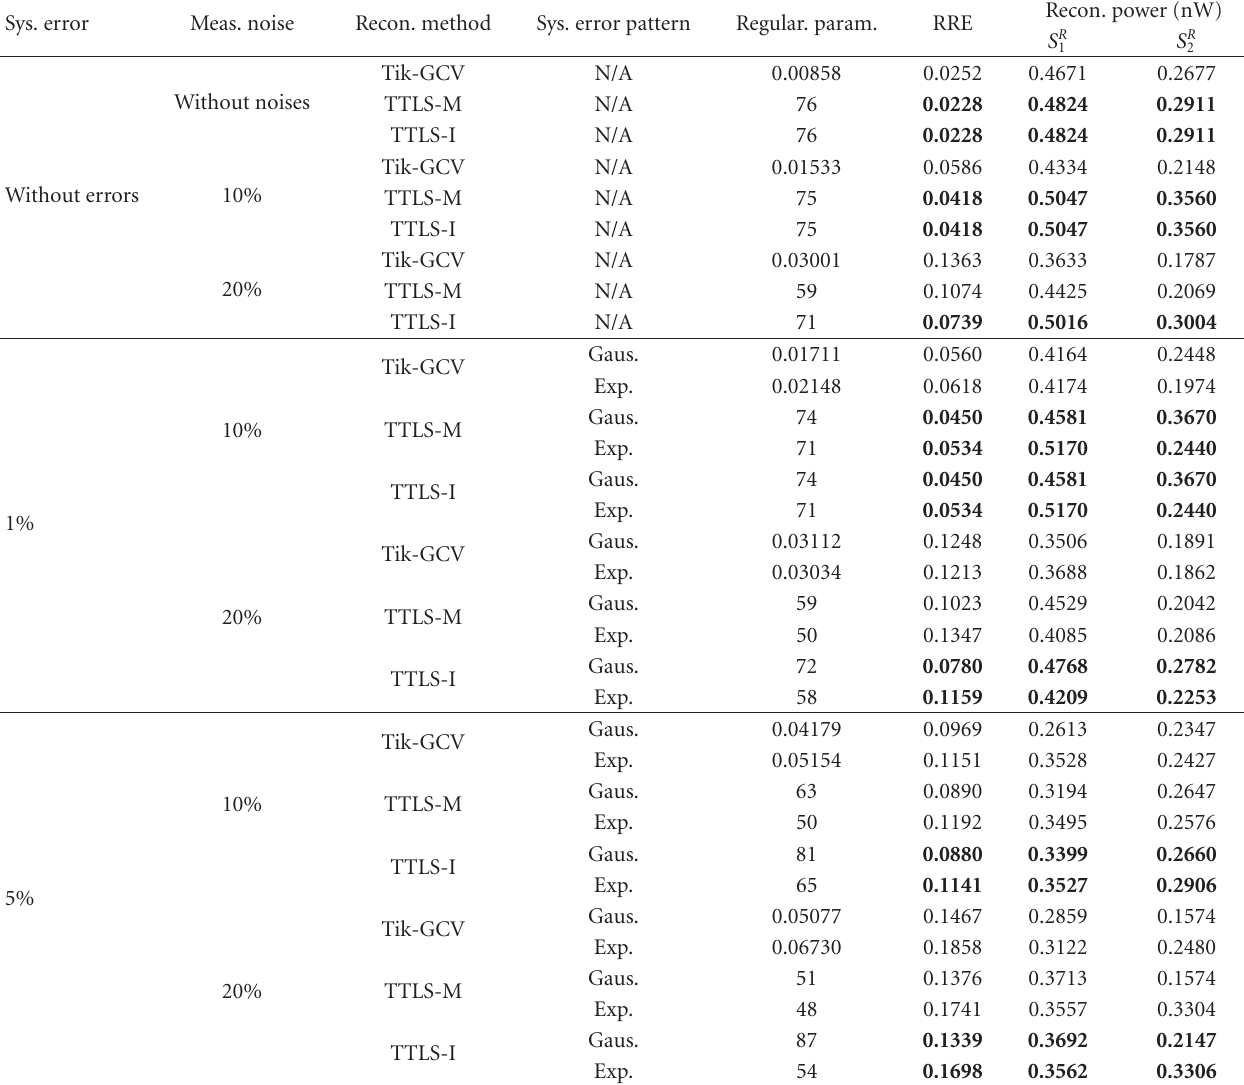
Table 3: Quantitative results in double source case.